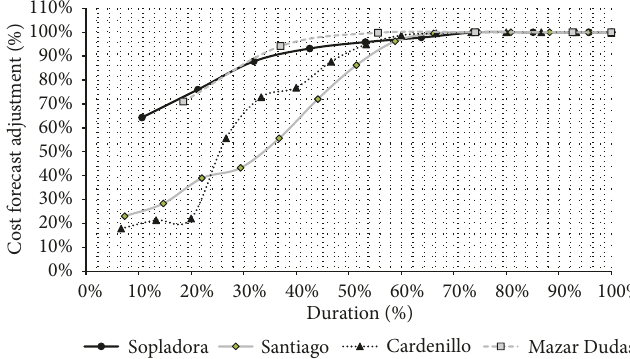
Figure 8: Cost forecasting accuracy with EVM over project execution time.